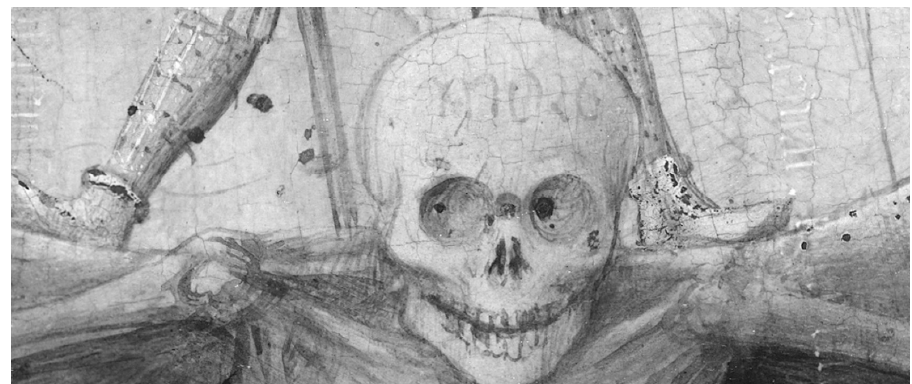
Figure 14. Infrared reflectography of the skeleton, detail of Figure 1.